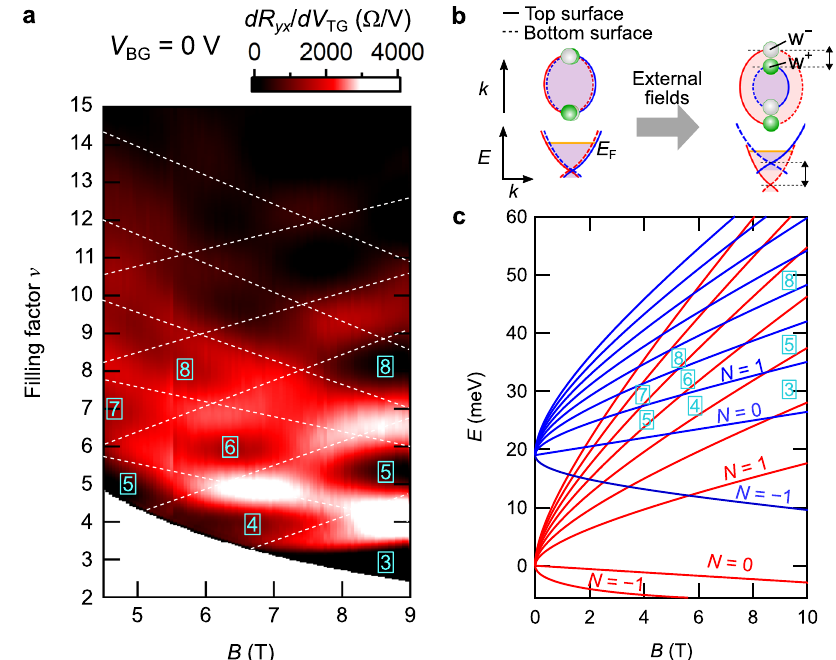
Fig. 4 Complex plateau transitions induced by external fi elds. a Mapping of the fi rst derivative of the Hall resistance R yx as a function of magnetic fi eld B and fi lling factor ν . The mapping is converted from the original B – n 2D mapping data via ν = n 2D h / eB (see also Supplementary Figs. 4 and 5). Plateau transitions between the quantum Hall states (corresponding to the brighter regions in the mapping) indicate the existence of multiple crossings of the Landau levels. The overlaid dashed lines are guides for eyes. b Schematic illustrations for the external- fi eld-induced splitting of the Weyl nodes of opposite chirality (W ± ) and consequent degeneracy lifting of the two Weyl orbits. c Fan diagram with complex Landau level crossings simulated by introducing an effective Zeeman splitting, and a relative energy shift between the two Weyl orbits (see Supplementary Note